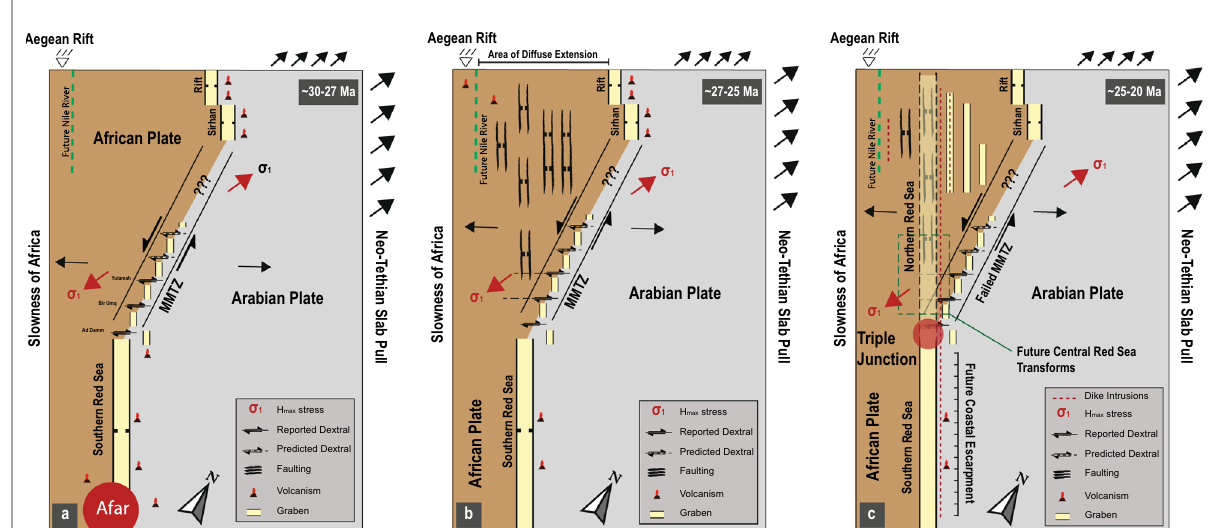
Fig. 2 Simplified tectonic maps of the plate boundary between Arabia and Nubia at ~ 30–28, ~ 27–25, and ~ 25–20 Ma. a At ~ 30–28 Ma, the plate boundary is delineated mainly by the distribution of pre-rift volcanic eruptions, particularly along the SRS and Sirhan rifts. The motion of Arabia with respect to Nubia is transferred from the SRS to the Sirhan rift through a transform zone (MMTZ). The southern segment of the MMTZ as denoted in the figure is later occupied by intensive volcanic eruptions. The northern segment of the MMTZ has no observed volcanic or structural expression. b At ~ 27–25 Ma, the MMTZ is still active in conjugate with diffuse extensional processes bounded spatially with the Nile River to the west, Sirhan rift to the east and the MMTZ to the south. This conjunction between SRS, NRS and MMTZ form the central Red Sea triple junction. This figure shows the volcanic activities distribution along the SRS, the Sirhan rift, and in the vicinity of the Nile River. The future central Red Sea transforms and curvature region is highlighted in green box as they correlate spatially with the MMN volcanics region. c At ~ 25–20 Ma, the effect of dike intrusions on the NRS rifting localization is illustrated, potentially causing the failure of cessation of the MMTZ and central Red Sea triple junction. The map also shows how the volcanic activities decreased significantly in the Red Sea region. The present-day central Red Sea region is highlighted in green